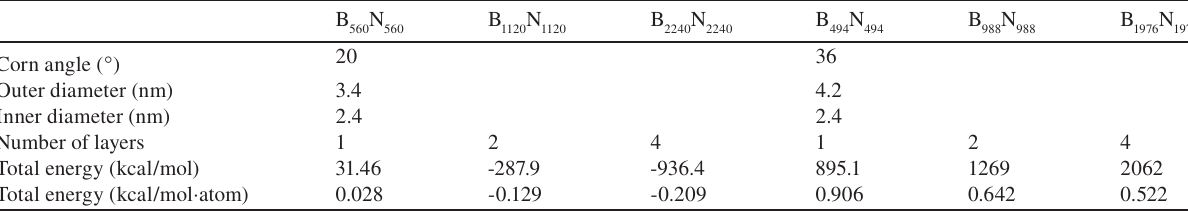
Table 7 Calculated values for various BN nanotubes with a cup-stacked